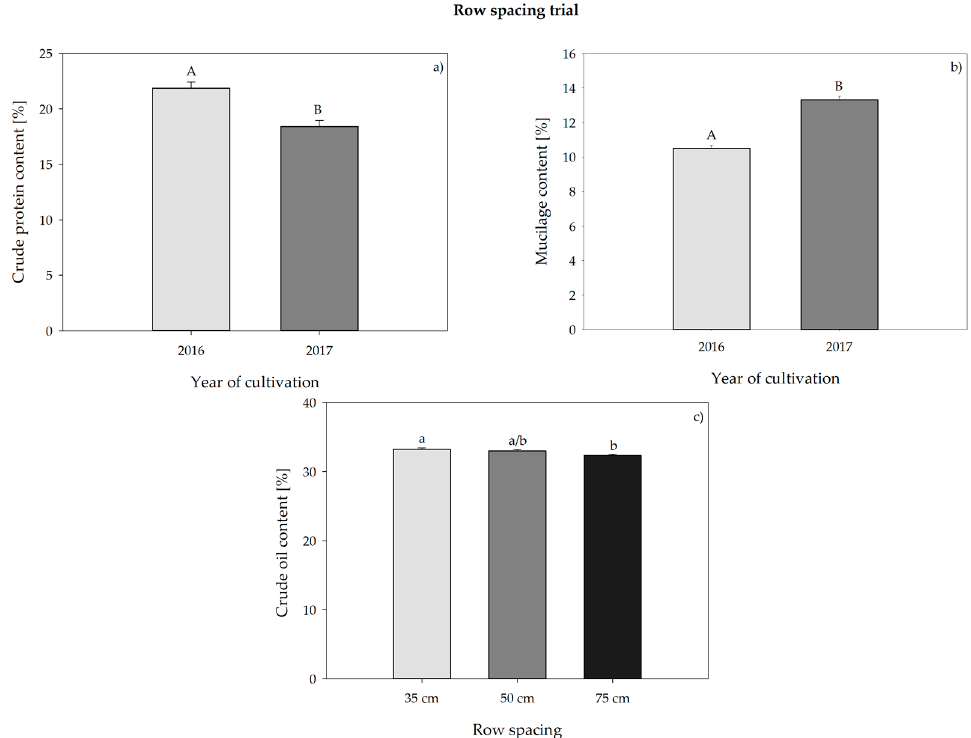
Figure 2. Mean estimates of crude protein ( a ), mucilage ( b ) and crude oil ( c ) content of the genotype G8 cultivated in 2016 and 2017 at Ihinger Hof with different row spacing. Means which share a common capital letter do not differ significantly between years at α = 0.05. Means which share a common lowercase letter do not differ significantly within row spacing at α = 0.05. (estimates, standard error, and Tukey HSD test are based on model (2); for F ‐ test results compare Table S1).